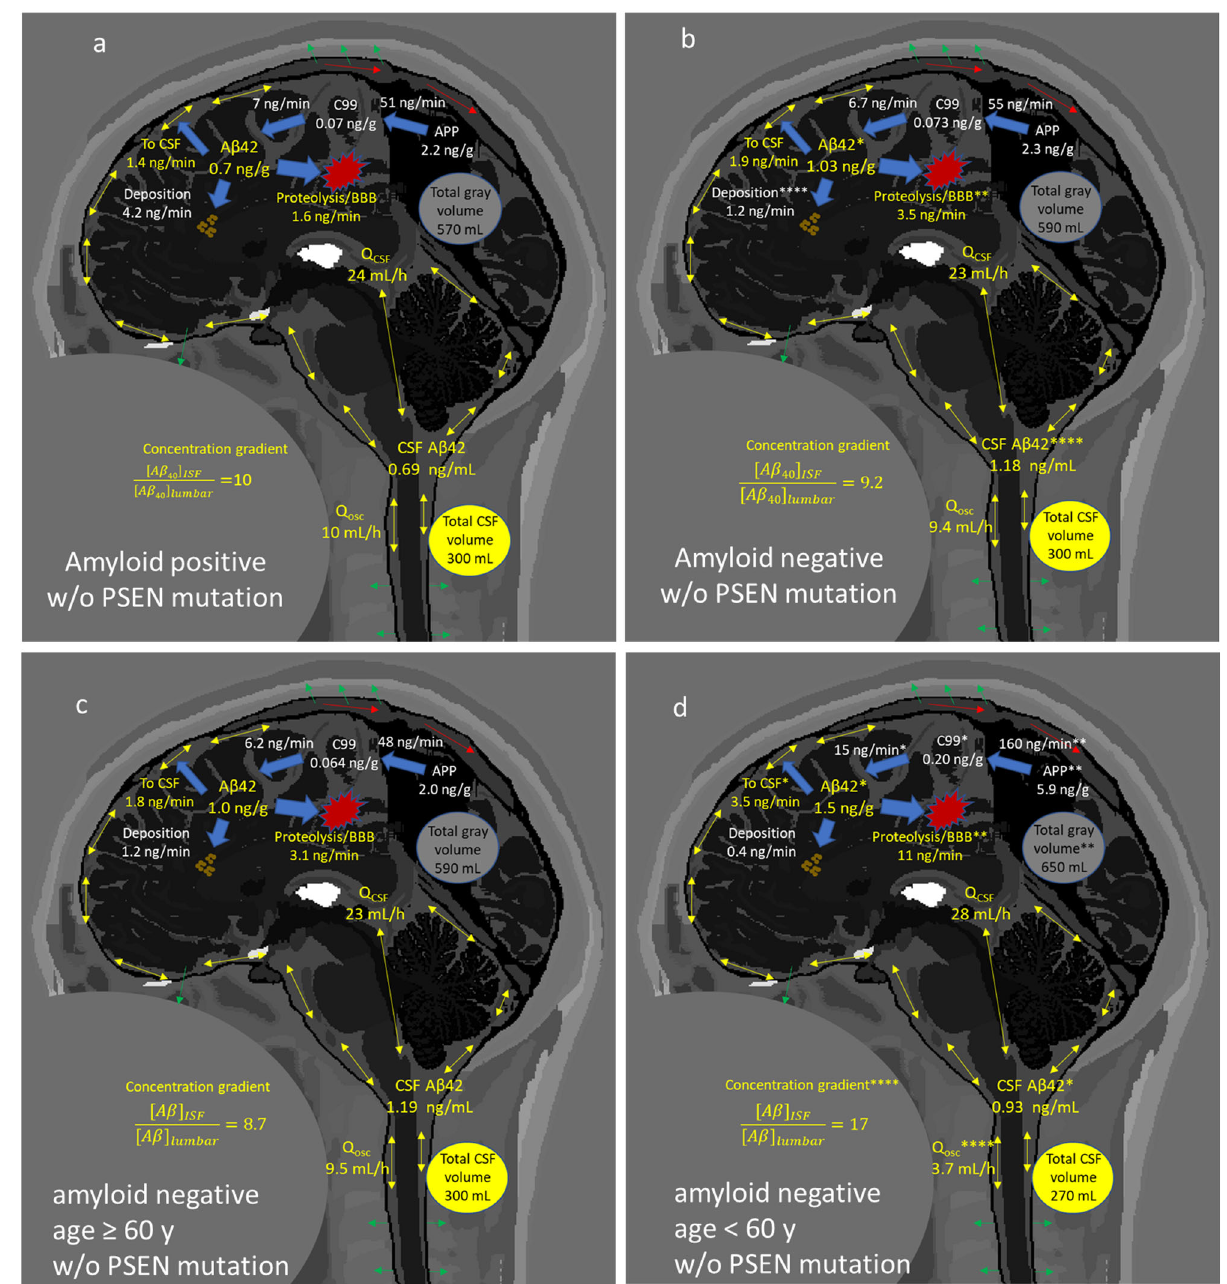
Fig. 6 Graphical summary of major results by amyloid status and age. Summary of major fi ndings. a , b In non-mutation carriers, the presence of amyloid plaques decreases the CSF and ISF concentration of A β 42 , due to enhanced deposition. This is despite the decreased mass fl ux across the blood – brain barrier or due to proteolysis, and a decrease in transfer from ISF to CSF. t test of predicted marginal means at age = 69.9 y: * P < 0.05, ** P < 0.01, *** P < 0.001, **** P < 0.0001. c , d In older amyloid-negative, non-mutation carriers, total gray volume and production of APP are reduced relative to younger subjects. This decreases the fl ux toward A β peptides, including A β 42 . However, the ISF concentration of A β 42 is only slightly elevated in younger subjects, because of greater fl uxes across the BBB or due to proteolysis and greater ISF-to-CSF transfer. In younger subjects, the concentration gradient of A β 42 from the ISF to lumbar space is larger, due to a smaller Q osc . t test: * P < 0.05, ** P < 0.01, *** P < 0.001, **** P < 0.0001. See Supplementary Table 6 for complete SILK, MRI, and PET . SILK data collection procedures and PET PIB measurements deposition of amyloid plaques was quanti fi ed by [ 11 C]PIB-PET in 77 subjects. were previously described 1,2 . Brie fl y, subjects received intravenous and intrathecal Subjects with mean cortical binding potential (MCBP) score >0.18 were considered to be amyloid positive. If PET PIB was not available, a lumbar CSF concentration lumbar catheters between 7 a.m. and 9a.m. The collection of samples began ratio A β 42 /A β 40 <0.12 was considered to be amyloid positive. PET PIB scans were between 8 a.m. and 10 a.m. Time zero CSF and plasma baseline samples were withdrawn, then 3mg/kg L -[U- 13 C 6 ]leucine was given as a bolus for 10 min, fol- performed within 3 years before or after the SILK tracer study date. MRI scans (3 T volumetric T1-weighted) were processed using FreeSurfer version 5.3 as previously lowed by a constant infusion of 2mg/kg/h for the remainder of the fi rst 9h. Blood described 86 . FDA, Center for Devices and Radiological Health, and IT ’ IS Foun- samples (12mL) were obtained hourly for the fi rst 16h and every other hour for the rest of the experiment (36 h). CSF (6 mL) was withdrawn hourly. The dation collected the MRI data used to generate the images in Fig. 6 87 .